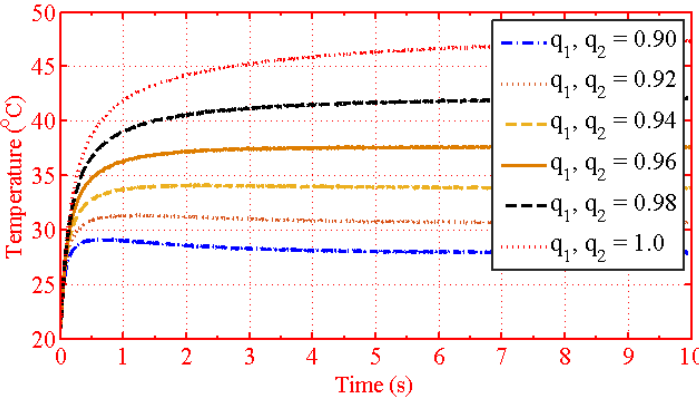
Figure 10. The output temperature in cold fluid as q 1 , q 2 ≤ 1.